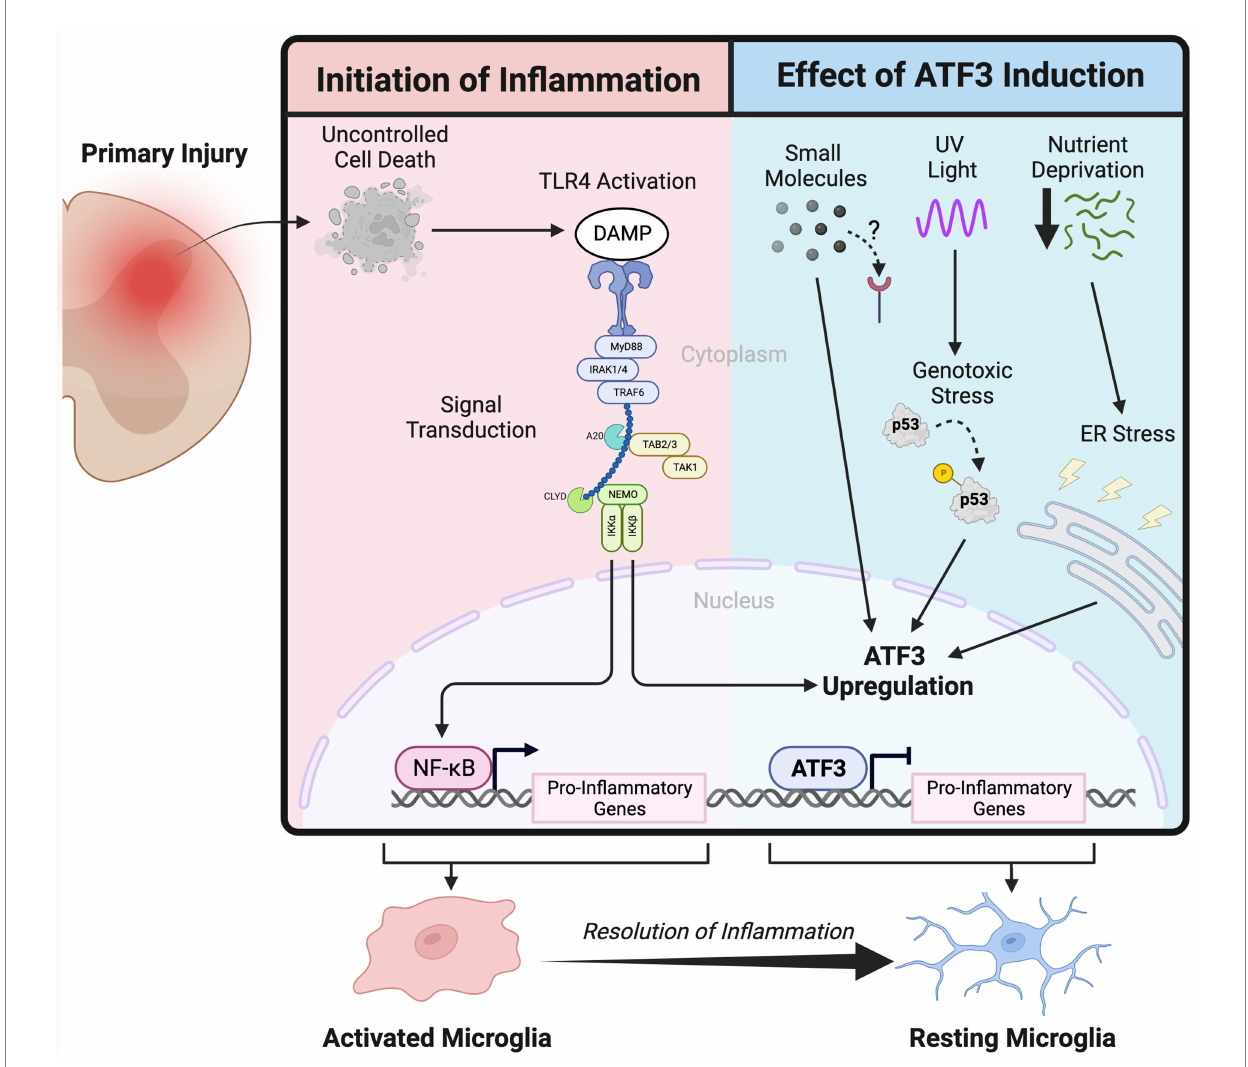
FIGURE 1 Schematic depicting the activation of the innate immune system following primary injury in the nervous system and the inflammation attenuation effect of Activating Transcription Factor 3